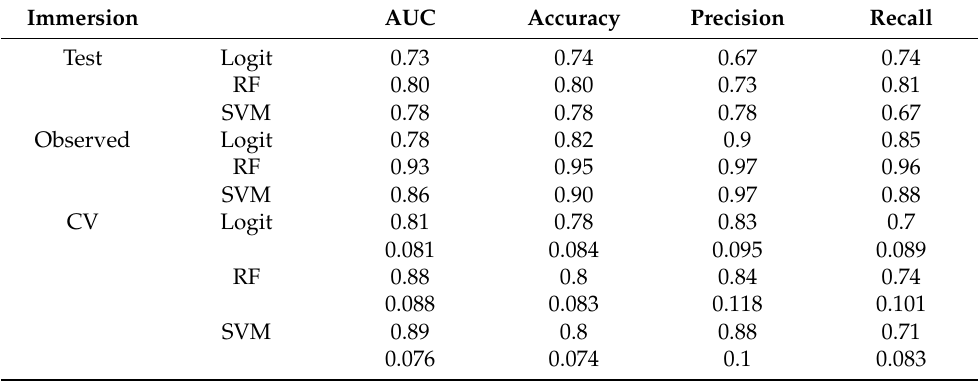
Table A9. ML classification of Energy using Immersion and PS in regularized logit, random forest (RF), and support vector machine (SVM) estimations. CV is